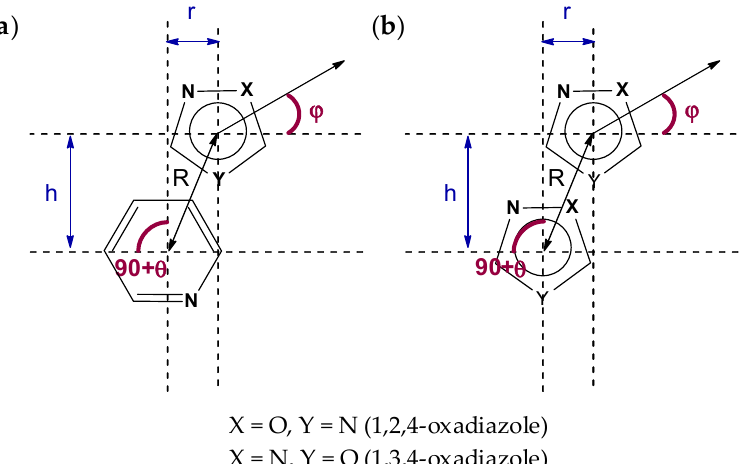
Figure 5. Characteristic parameters of the π ··· π interactions between oxadiazole and pyridine rings ( a ) and oxadiazoles rings ( b ).